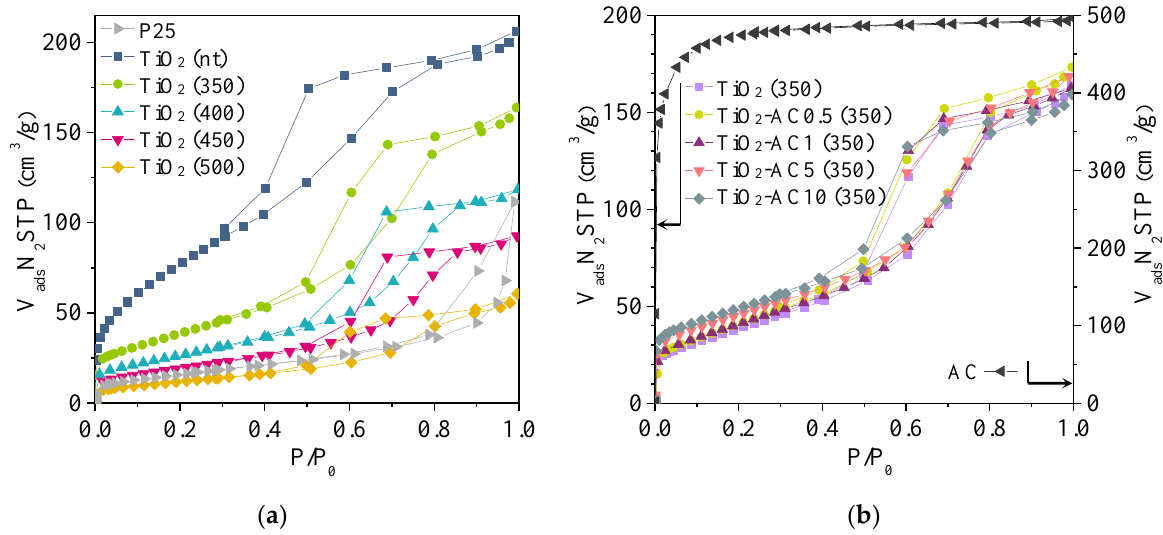
Figure 1. N 2 adsorption-desorption isotherms at − 196 °C for: ( a ) P25, TiO 2 (nt) and TiO 2 (T) samples and ( b ) AC, TiO 2 (350) and TiO 2 -ACx (350) samples.